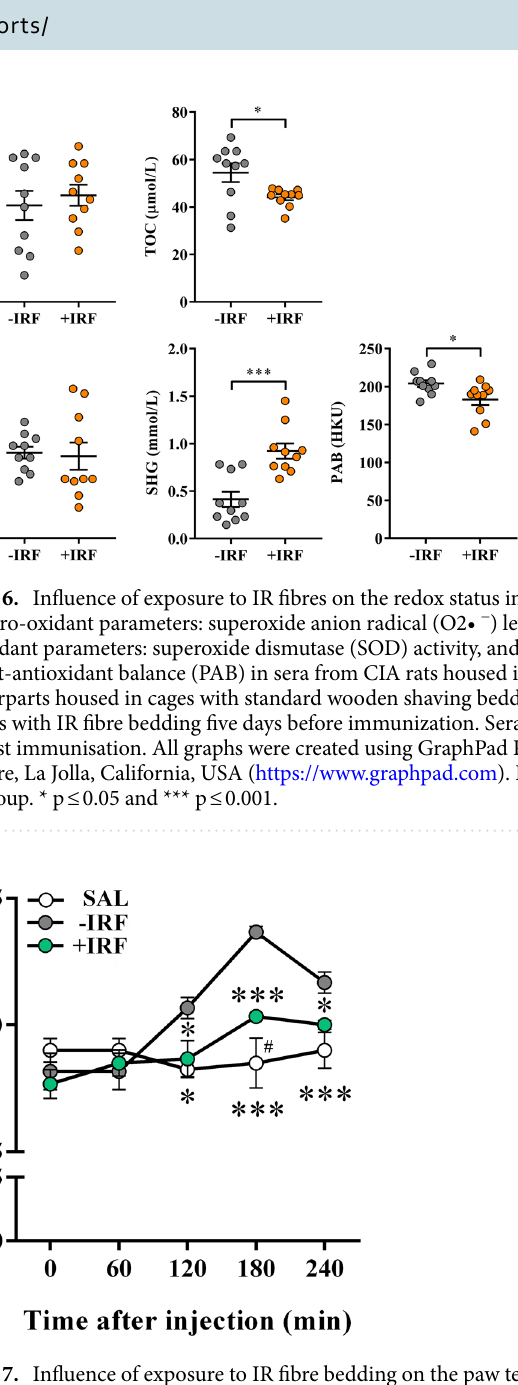
rats (Fig. 9). Differently, the production levels of TNF-α in inflamed paw tissue cultures from +IRF rats did not statistically significantly differ from those in inflamed paw cultures from −IRF rats (Fig. 9). On the other hand, the production levels of TGF-β were higher (p ≤ 0.01) in cultures of inflamed paw tissues from +IRF rats compared with those from −IRF ones, whereas those of IL-10 were comparable between these cultures (Fig. 9).